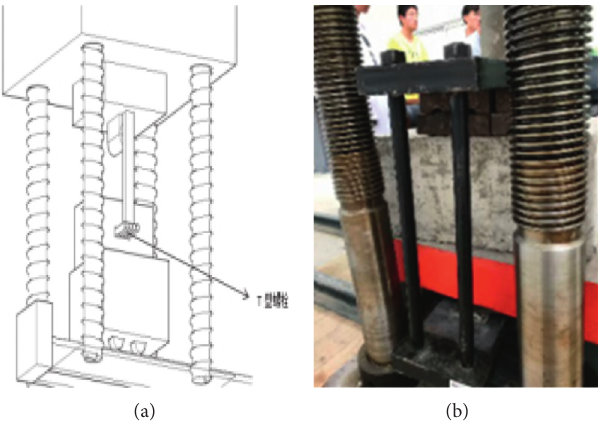
Figure 2: (a) Servo testing machine structure diagram. (b) Self-control experiment